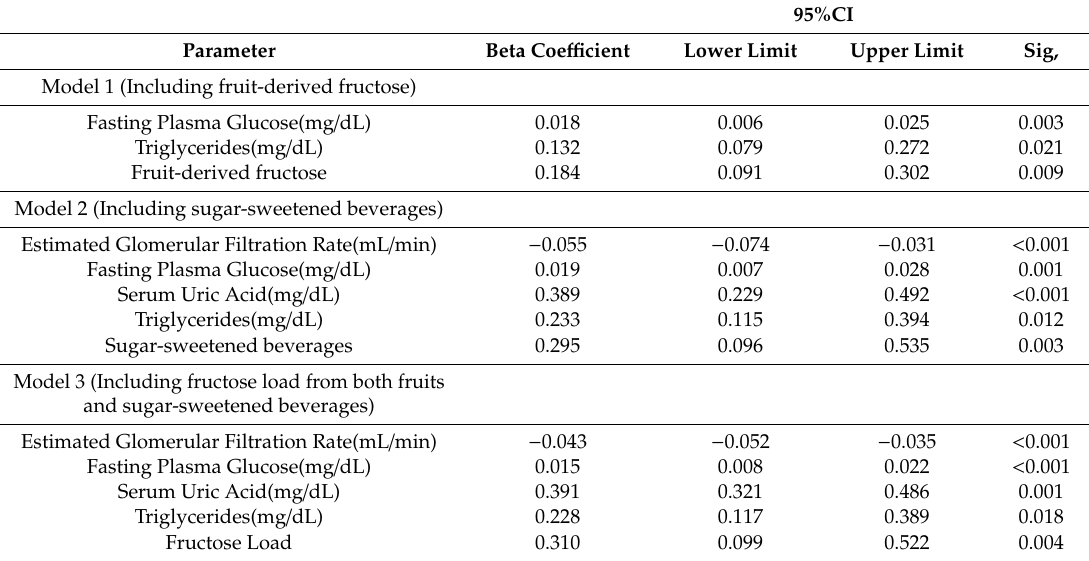
Table 4. Parameters associated with pulse wave velocity in age, gender and mean arterial pressure adjusted models (stepwise multiple regression analysis; the beta coe ffi cient is the degree of change in the outcome variable for every 1-unit of change in the predictor